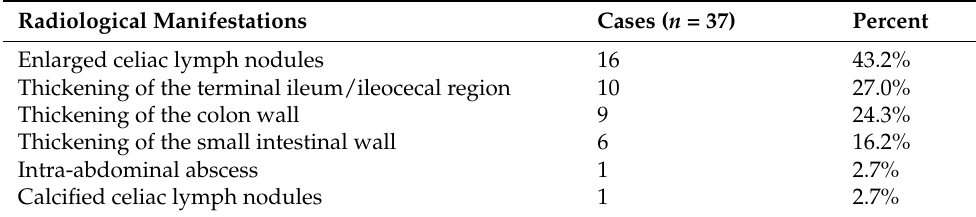
Table 5. Abdominal CT examination findings of patients with intestinal tuberculosis.